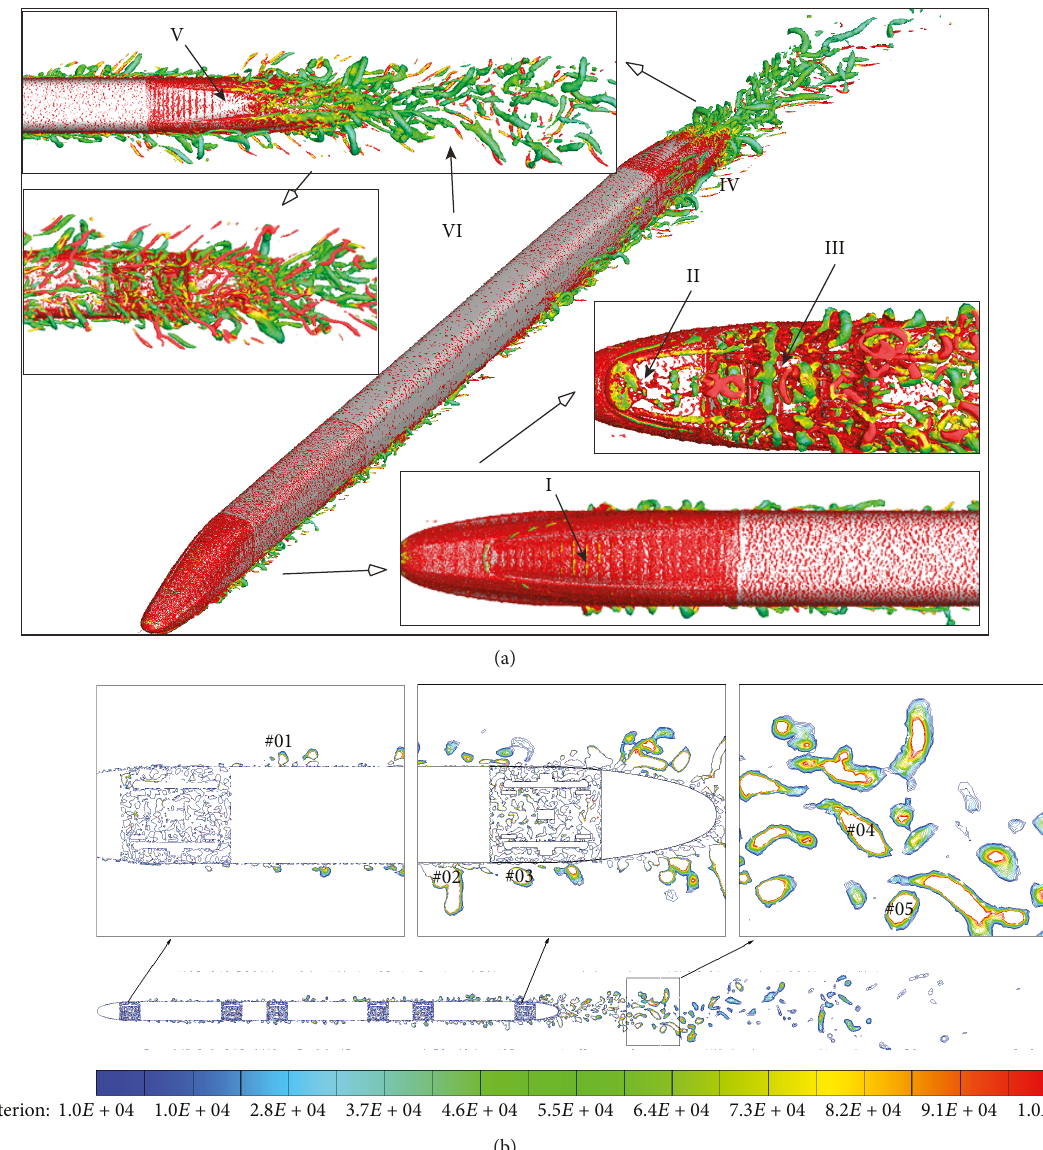
Figure 11: Vortex structure (free fl ow speed: 83m/s): (a) instantaneous isosurface plot of Q = 200, 000/s 2 , colored by vorticity and (b) contour map of Q value on the x - y surface that is 0.125m above the